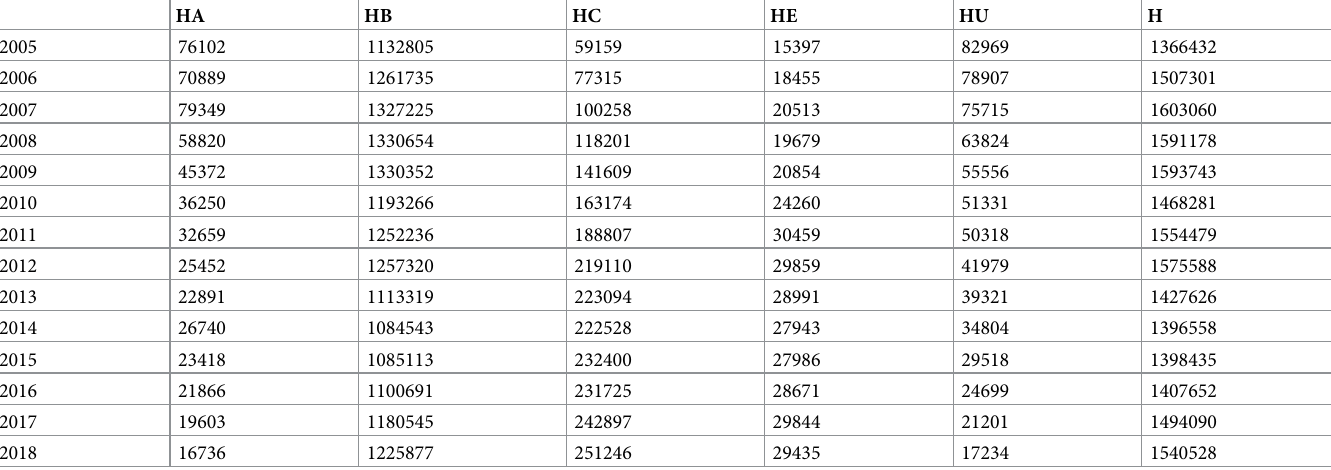
Table 1. Numbers of cases caused by hepatitis diseases in China.